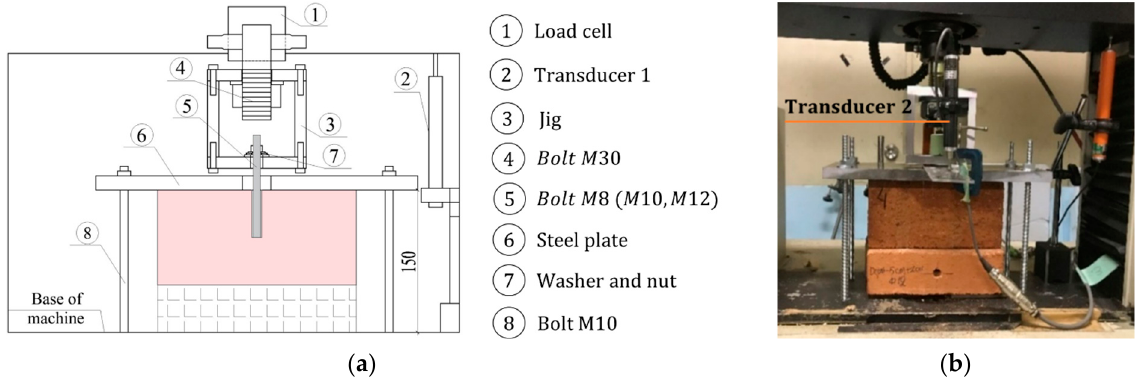
Figure 3. Setup of the pullout test. ( a ) Schematic setup; ( b ) Photo of setup.